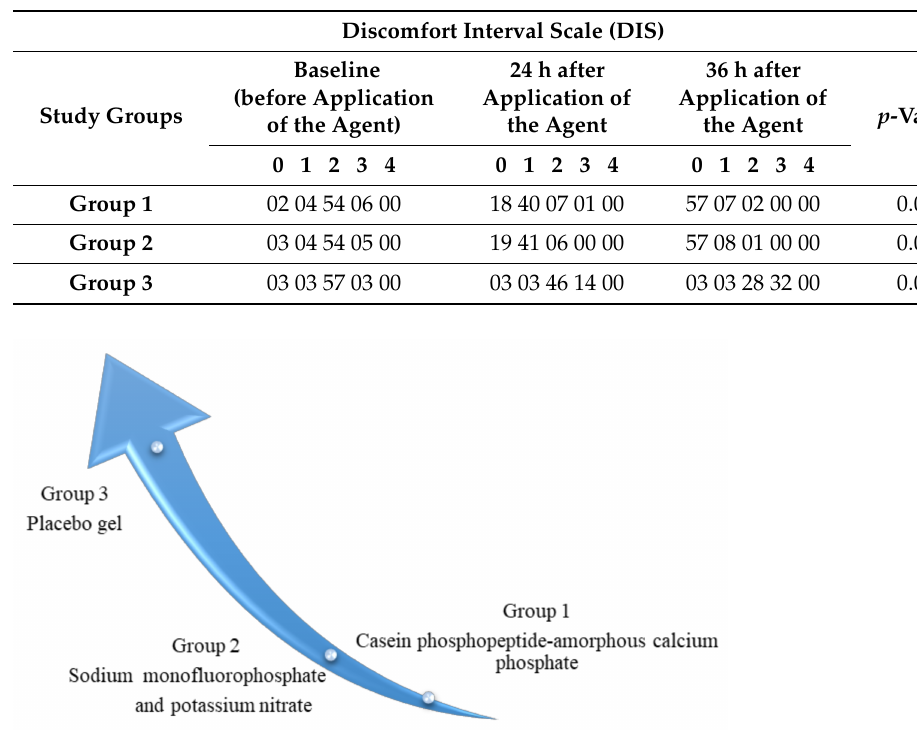
Table 1. Comparison within different groups before and after application of desensitizing agents.